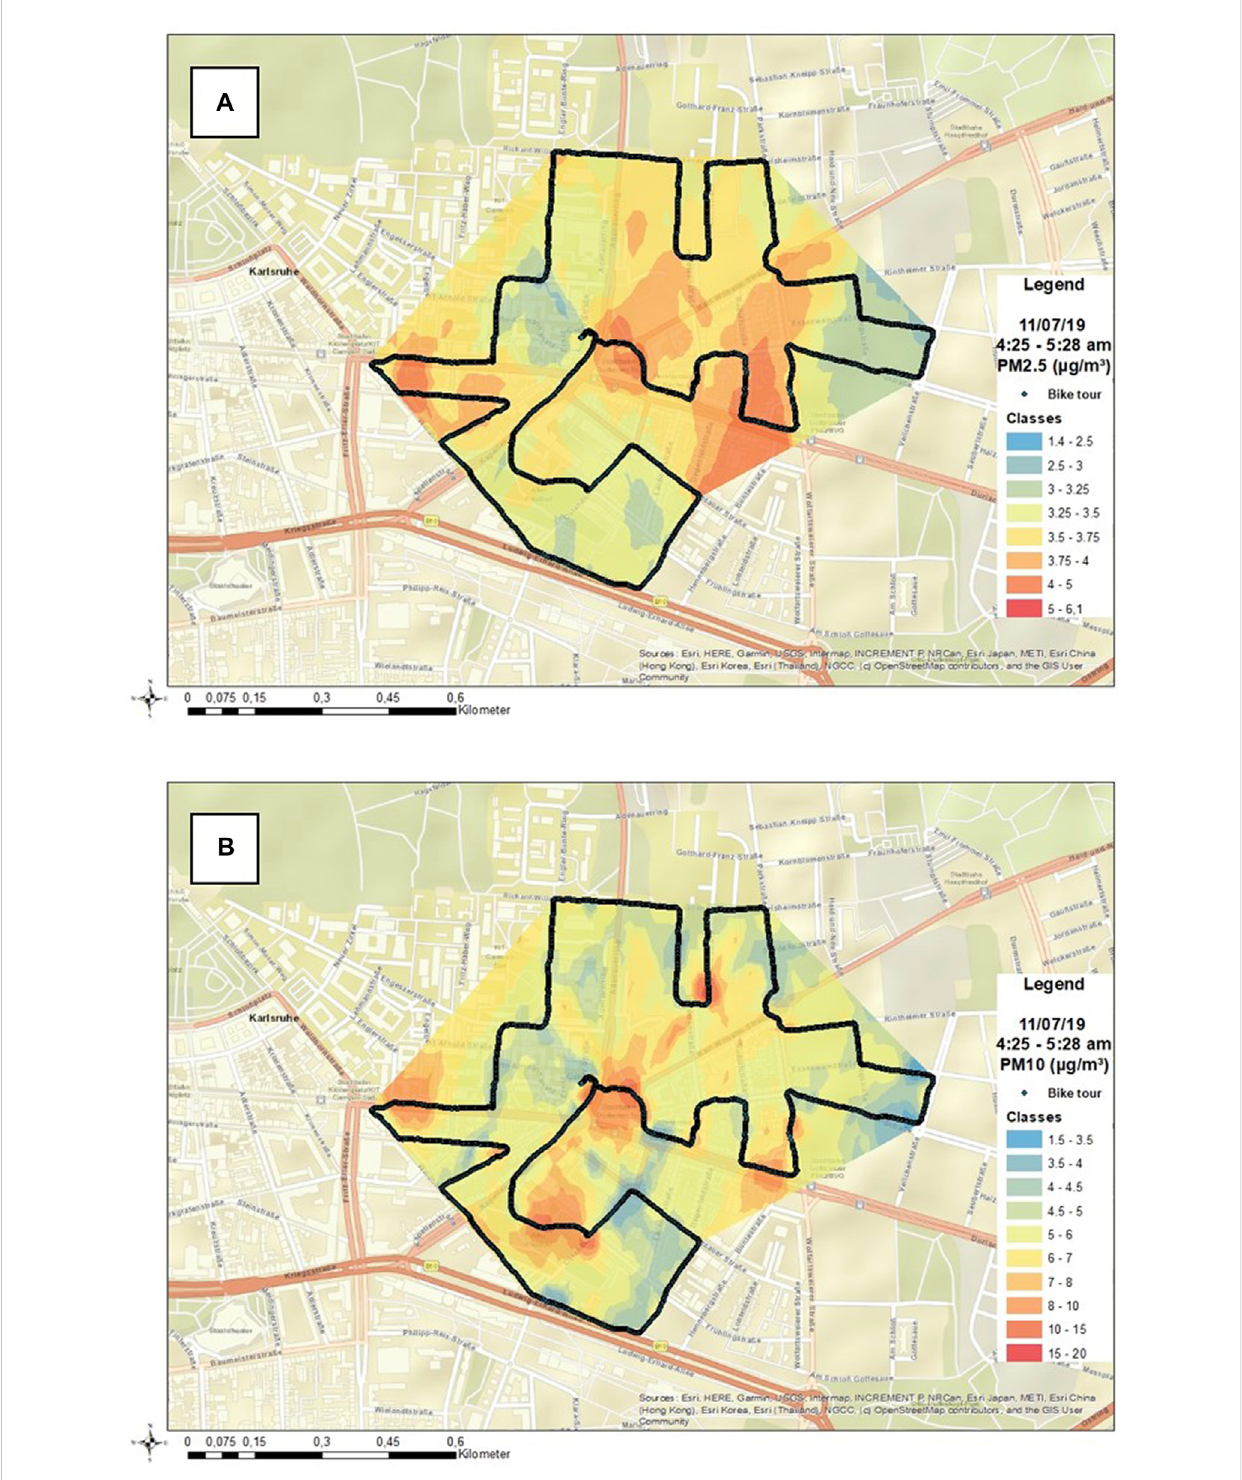
aerosol plume in the area of investigation. In the afternoon of the 9 th of July highest wind velocities occurred with up to 5.4 m/s. During the other measurement periods the velocities